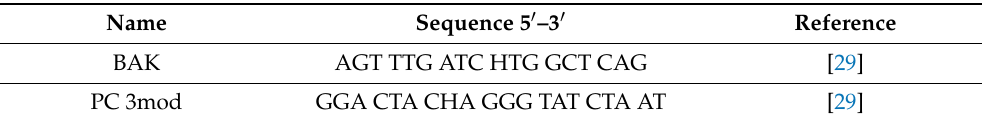
Table 2. Primers used in this